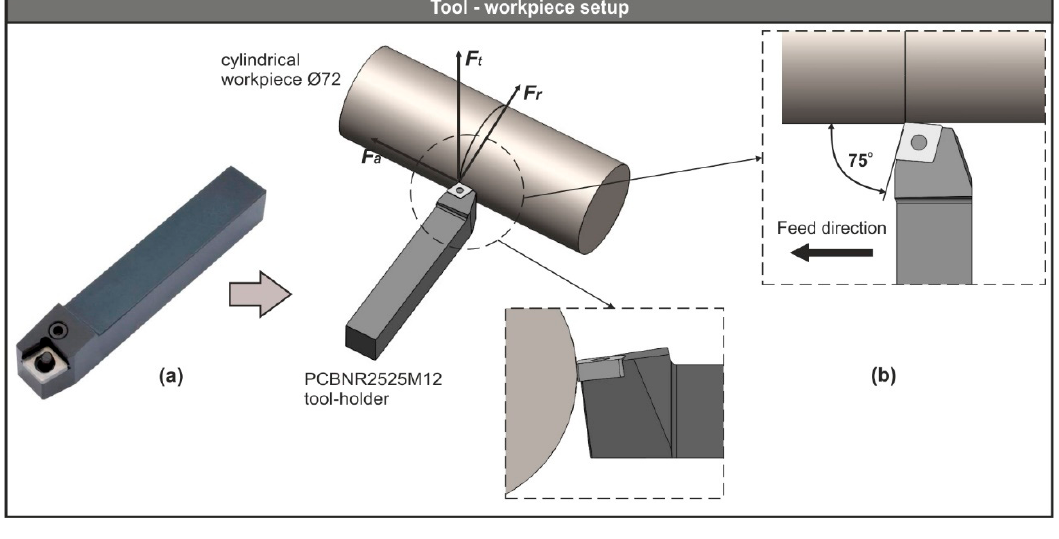
Table 1. Process conditions of the turning finite element (FE)